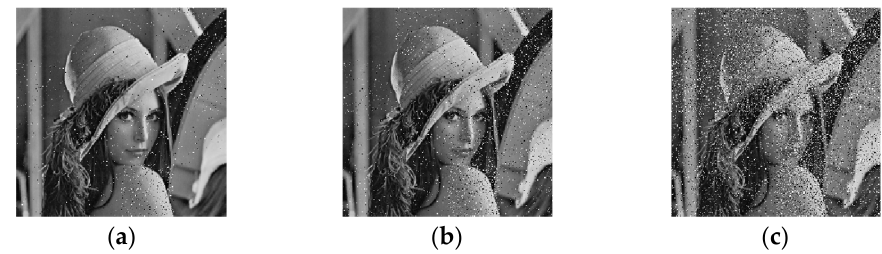
Figure 10. Cropping attack. Data loss with ( a ) 30 × 30; ( b ) 50 × 50; ( c ) 100 × 100.